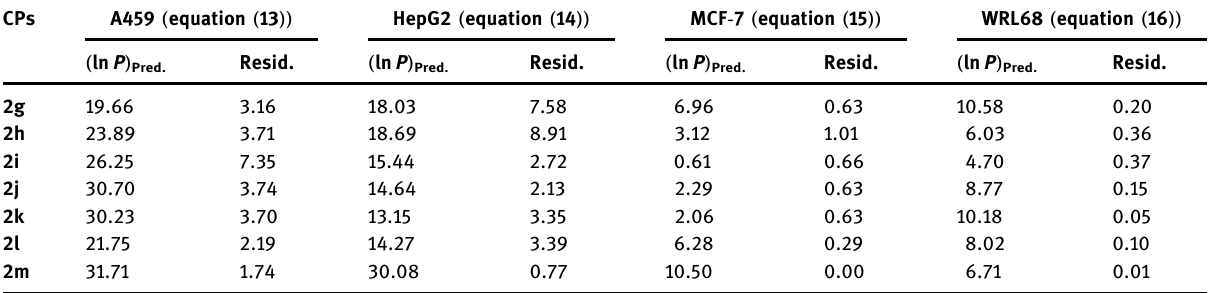
Table 11: Predicted percentage inhibition and residuals obtained by using MLR equations ( 13 ) – ( 16 ) and considering compounds 2g – 2m CPs A459 ( equation ( 13 )) HepG2 ( equation ( 14 )) MCF - 7 ( equation ( 15 )) WRL68 ( equation ( 16 )) ( ln P ) ( ln P ) ( ln P ) Pred. Resid. Pred. Resid.